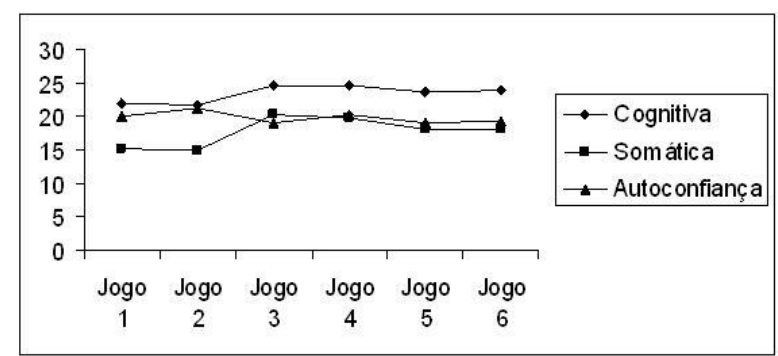
Figura 1. Índices da “ansiedade estado” na fase pré